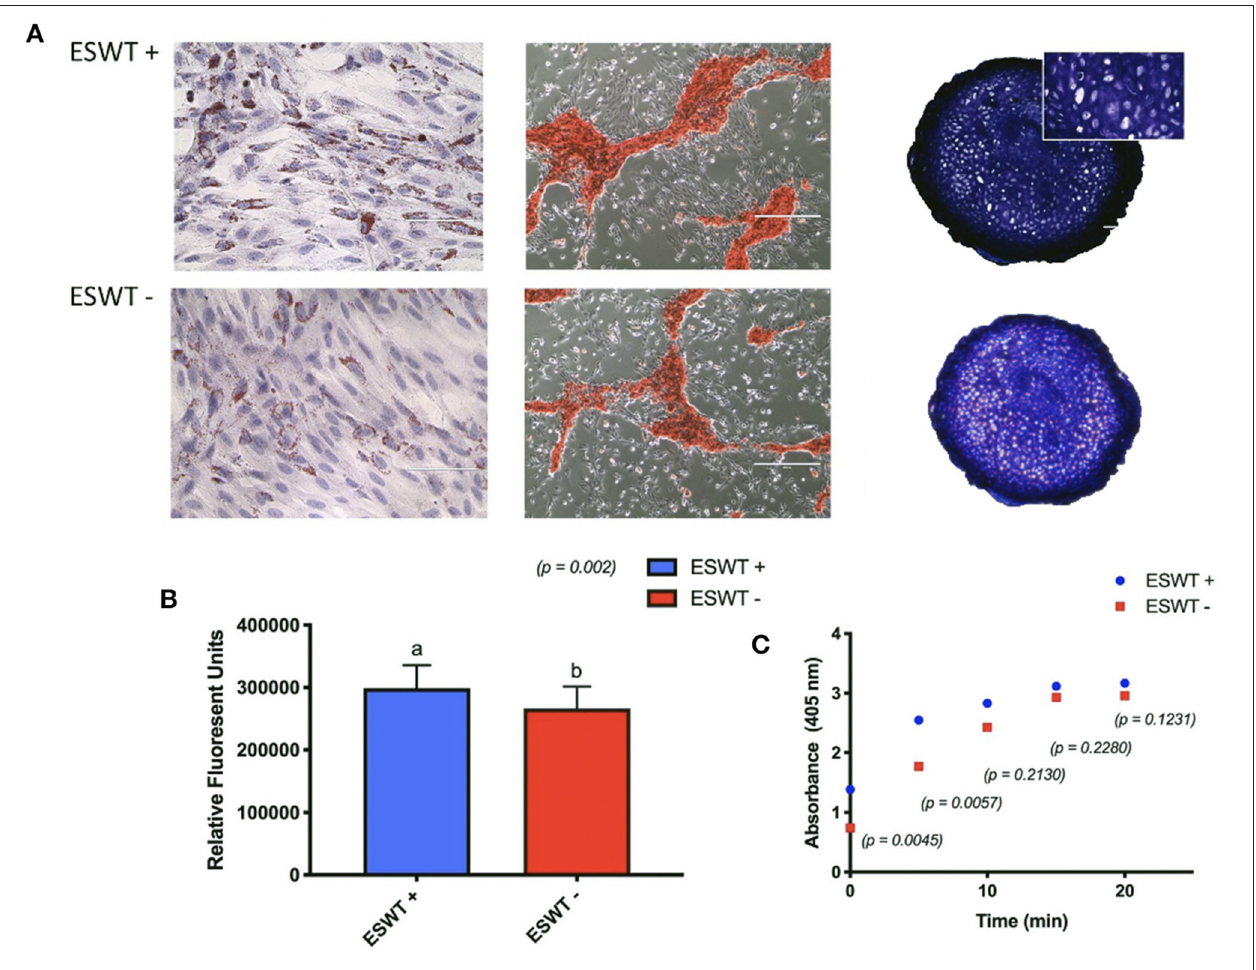
FIGURE 6 | Trilineage differentiation. (A) Positive trilineage potency for adipogenesis (Oil Red O), osteogenesis (Alizarin Red S), and chondrogenesis (Toluidine blue) for treated (ESWT + ) and untreated (ESWT–) equine CB-MSC. (B) Quantification of intracellular lipid droplets by relative fluorescent units for treated (ESWT + ) and untreated (ESWT–) equine CB-MSC. Results are shown as mean and CI 95% ( p = 0.0002). Values with different letters are statistically different ( p = 0.002). (C) Alkaline phosphatase activity measured in relative fluorescent units in treated (ESWT + ) and untreated (ESWT–) equine CB-MSC. Differences were found at time 0 ( p = 0.0045) and 5mins ( p =